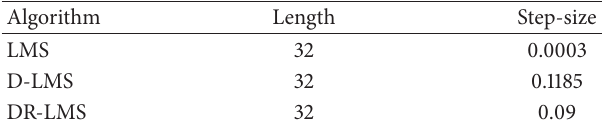
Figure 6: System identification. Table 1: Simulation